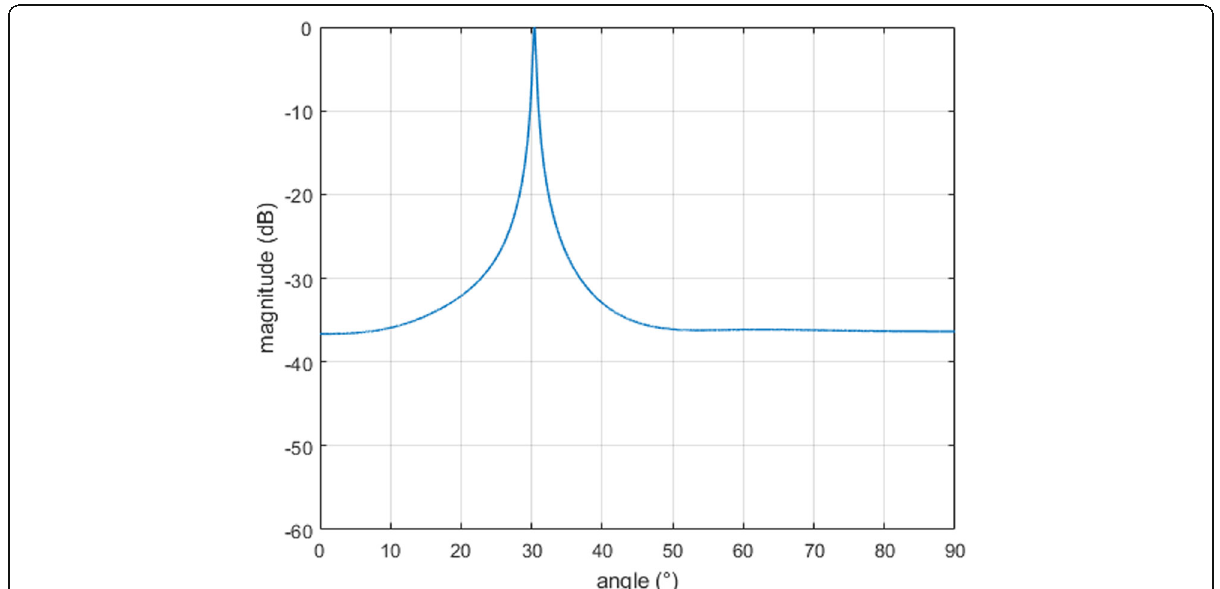
Fig. 9, different values of the same order have little influ- ence on RMSE. Figures 10 and 11 show the estimated spatial spectrum of TF-MUSIC based on cross terms and the traditional MUSIC where the direction separation is close ( θ θ = 33°). It is obvious that the source signals can 2